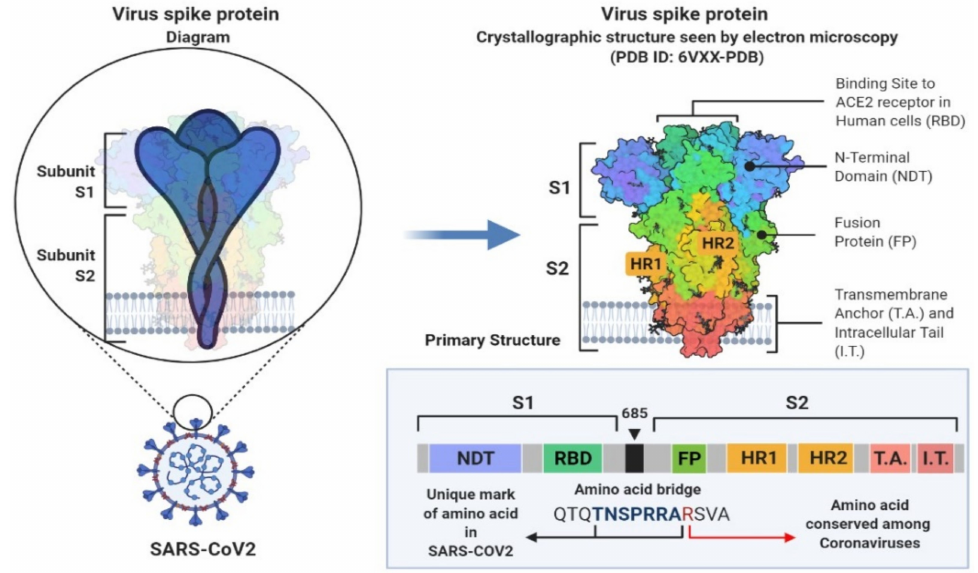
Figure 2. Crystallographic structure SARS-CoV-2. Figure was created using by BioRender (https://biorender.com, accessed on 15 September